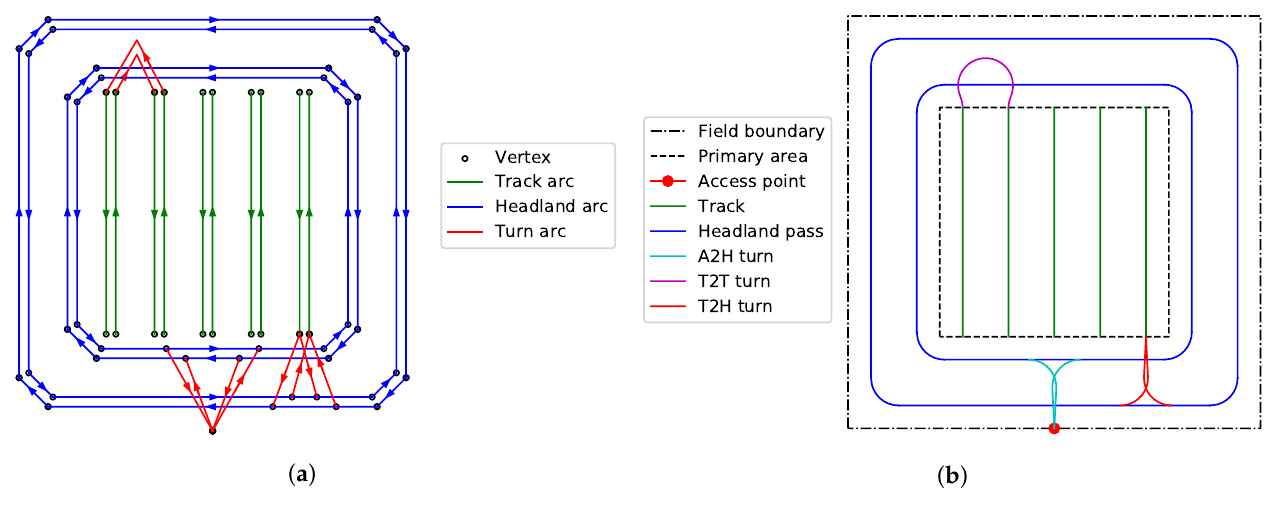
Figure 4. Aerial photograph of the field presented in Figure 3. The field boundary is marked in yellow and field entry/exit segments are marked in red. There are five visible main field traffic lanes and the headland traffic lane is also visible. The field traffic lanes are oriented in the same direction as defined for the field partitioning as illustrated in in Figure 3.